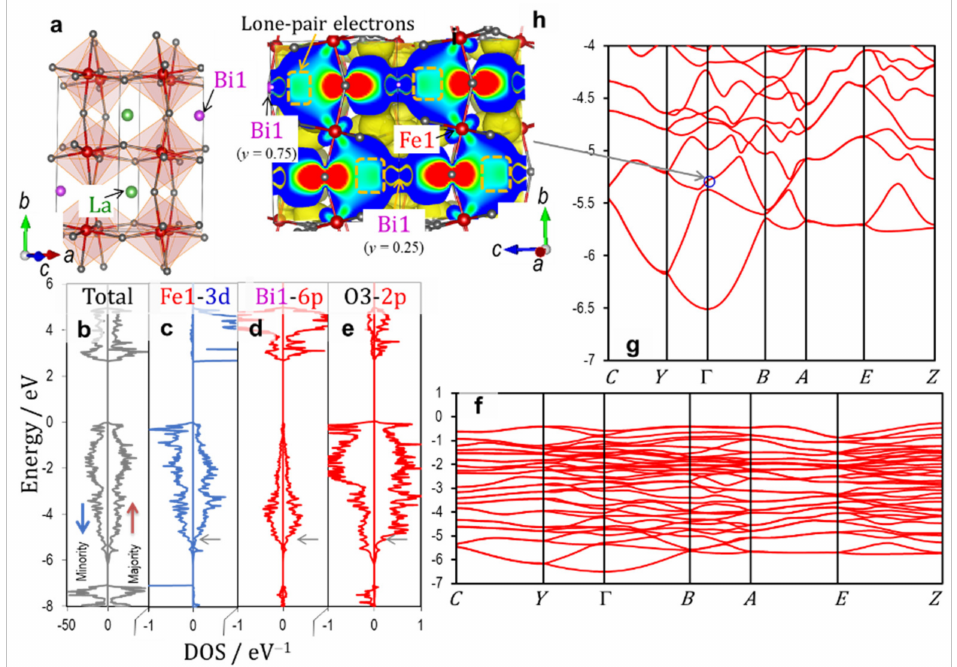
Figure 7. Crystal structure ( a ), electronic density of states (DOS) ( b – e ), band structures (of the majority spin band) in the valence band ( f , g ), and ( h ) wavefunction of the band shown in the blue circle of the orthorhombic cell ( x = 1/2). The up (red) and down (blue) arrows in ( c ) denote the majority and minority spin bands, respectively. The horizontal arrows (gray) in ( c – e ) correspond to the energy level of the blue circle in ( g